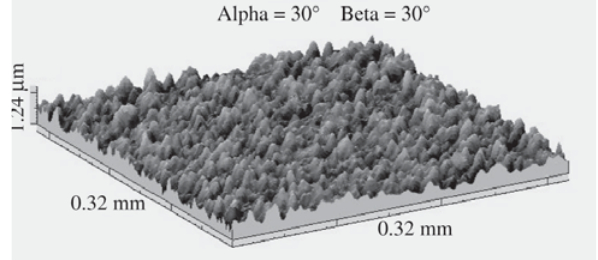
Figure 3. Three dimensional plot of titanium surface after alkali treatment with NaOH aqueous solution at 130 °C for 1 h and sub- sequent heat treatment at 600 °C for 1 h by contact profilometry